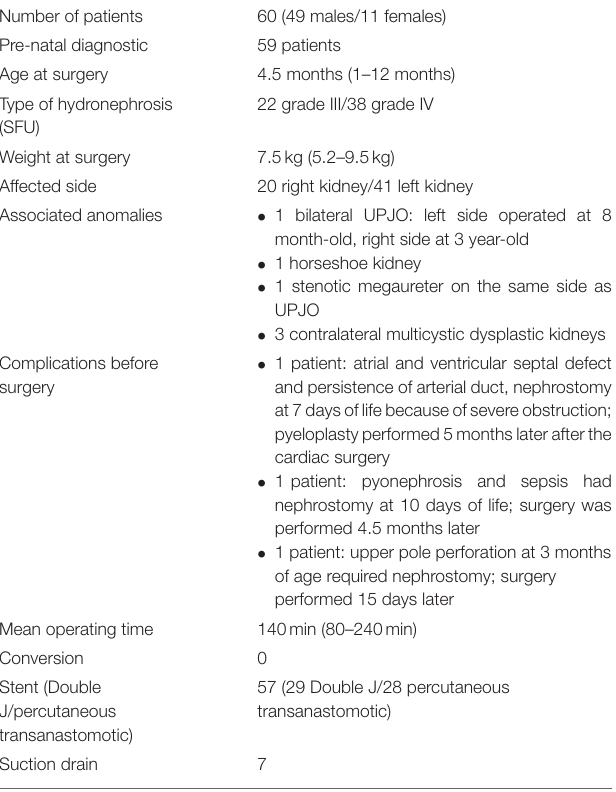
TABLE 1 | Patients’ demographics.